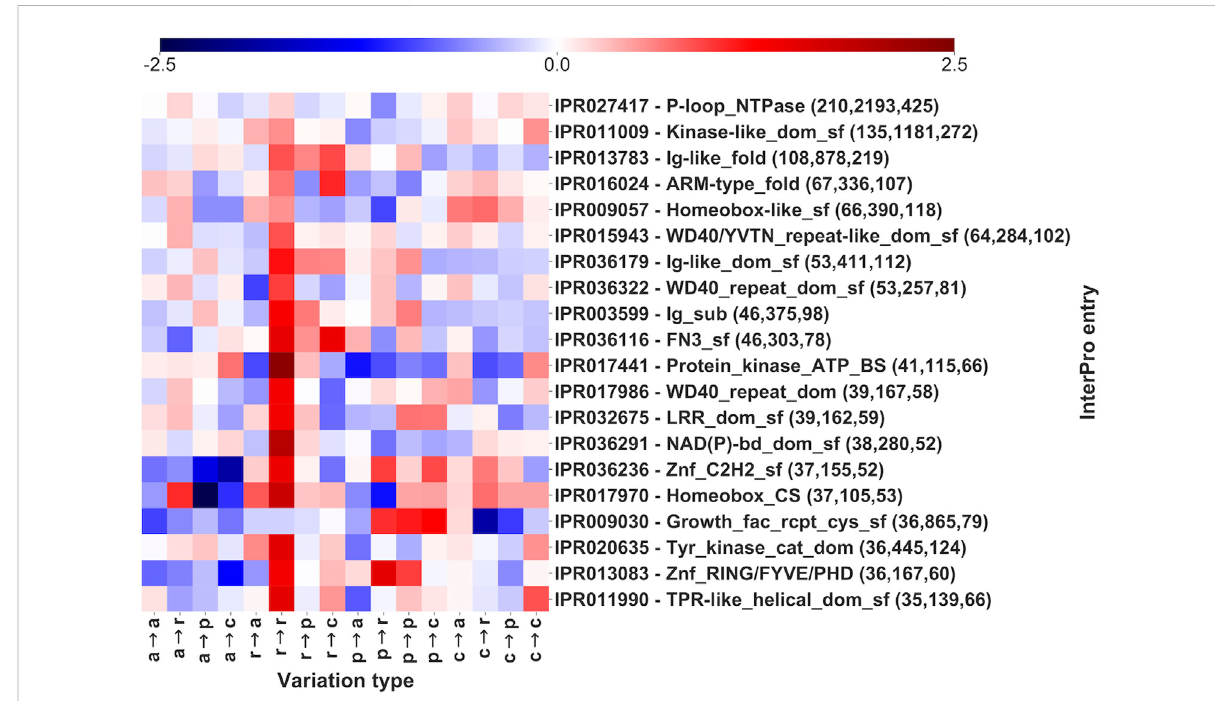
FIGURE 6 Log-odd scores of variation types for the fi rst 20 InterPro entries (out of 5,357, Table 2), sorted by number of genes covered and not including Pfam signatures. Log-odds are computed with respect to the whole dataset LP/P background (Figure 3). Numbers in parentheses report, for each InterPro, the number of genes, of SRVs and of diseases, respectively. The log-odd values are affected by a relative error lower than 5%, as estimated with a bootstrapping procedure. Statistical validation and resulting FDR-corrected p -values for each InterPro entry are reported in Supplementary Table